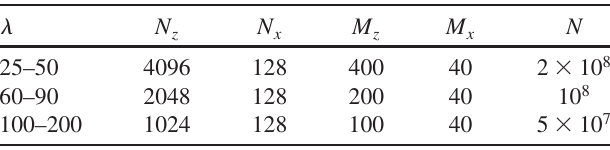
TABLE III. Values for the parameters used in simulations in Figs. 11, 12, and 23. The number of particles per cell is fixed at